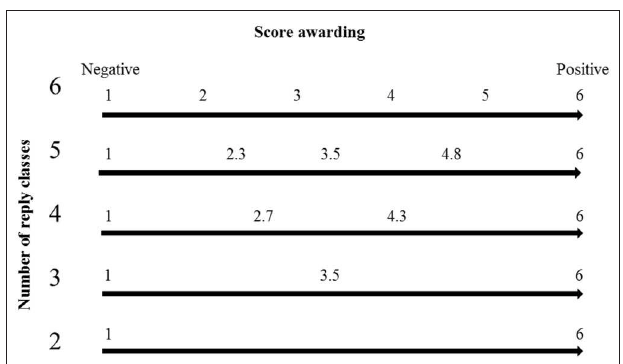
FIGURE 2 | Score awarding for the animal hygiene indexes (CAHI, TAHI) for two to six reply classes.